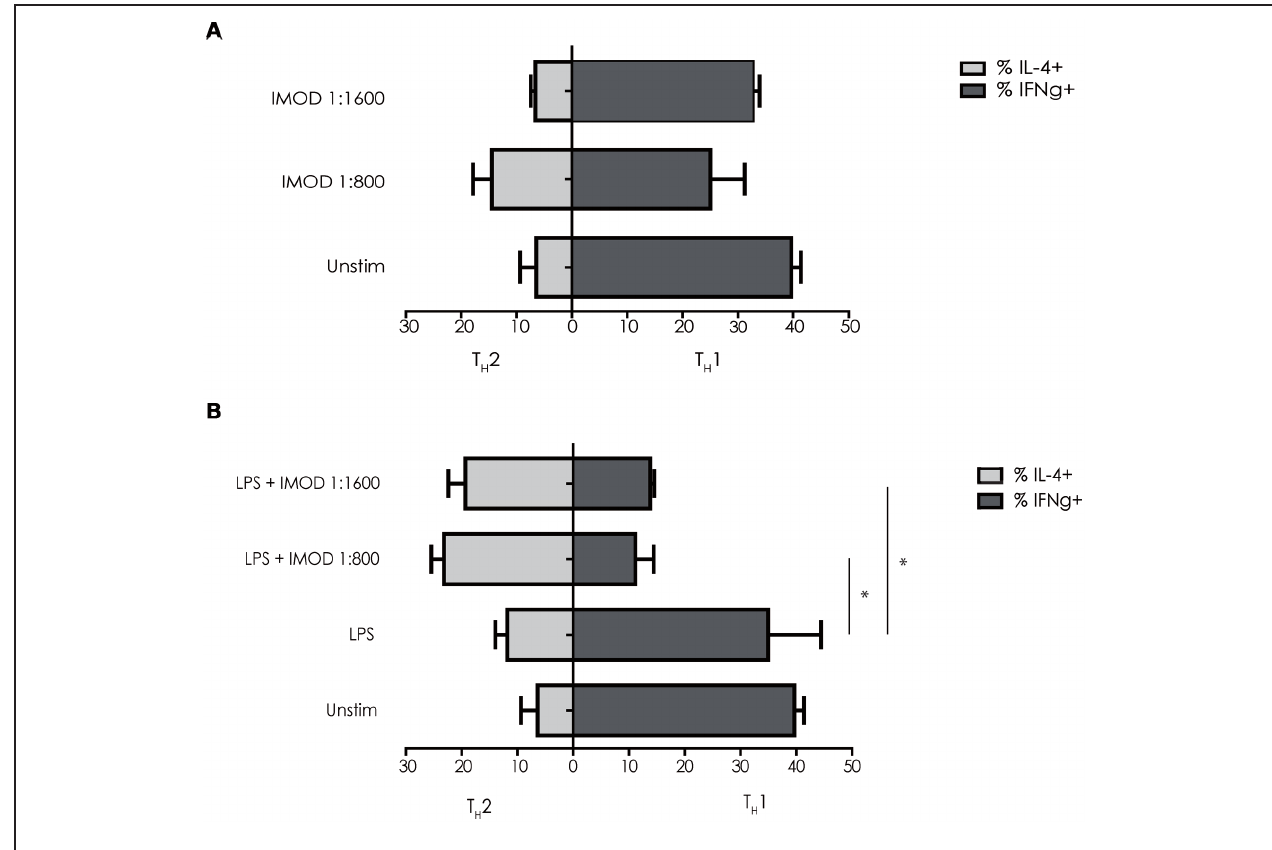
FIGURE 5 | IMOD skews T helper cell polarization toward T H 2. Immature dendritic cells were incubated for 48 h with IMOD in the presence (B) or absence (A) of LPS (10 ng/mL). Next naïve CD4 + T cells were added and after 13 days of co-culture the differentiation was